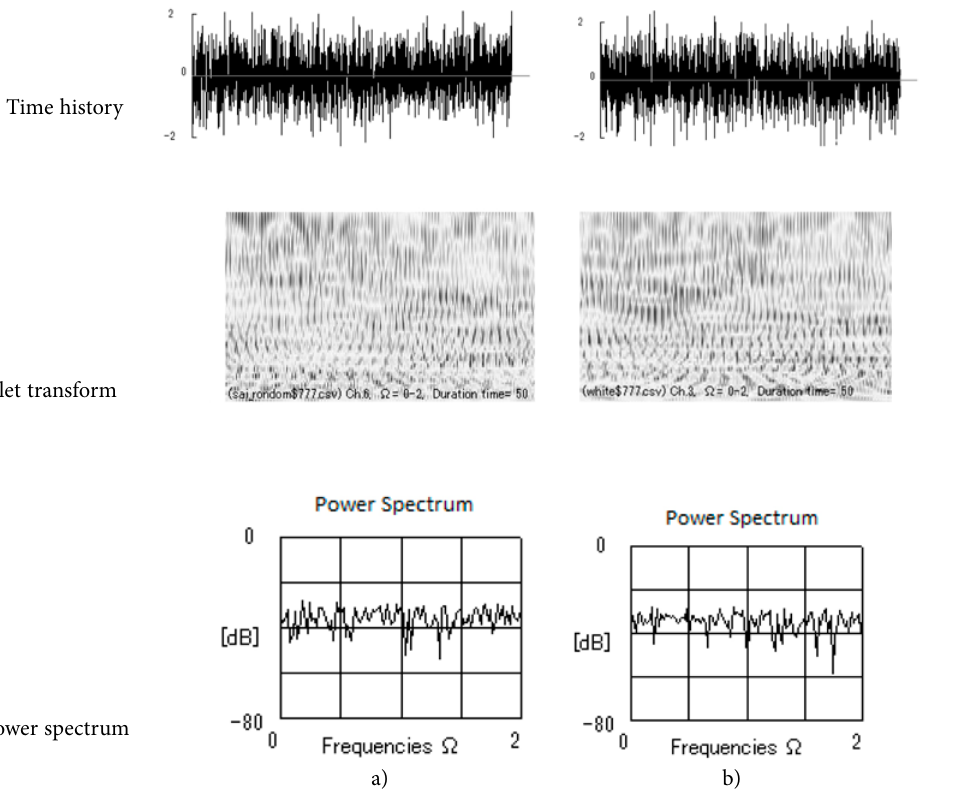
Fig. 3. (a) Time Domain Method, (b) Present IDFT